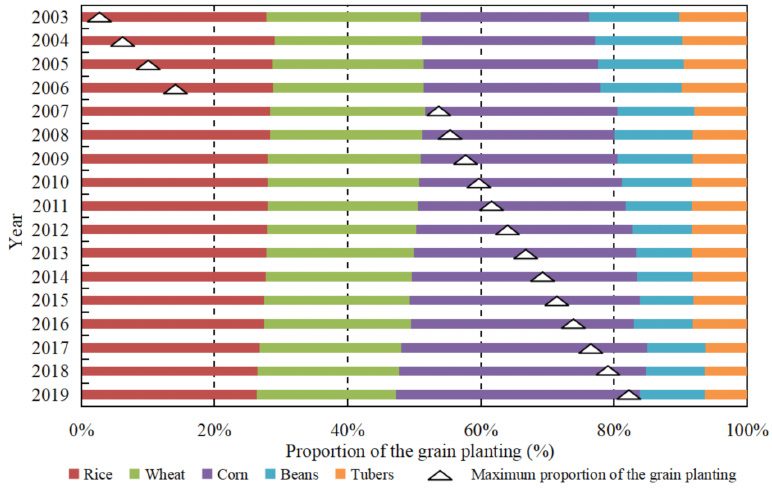
Figure 3. Changes of grain planting structure in China from 2003 to